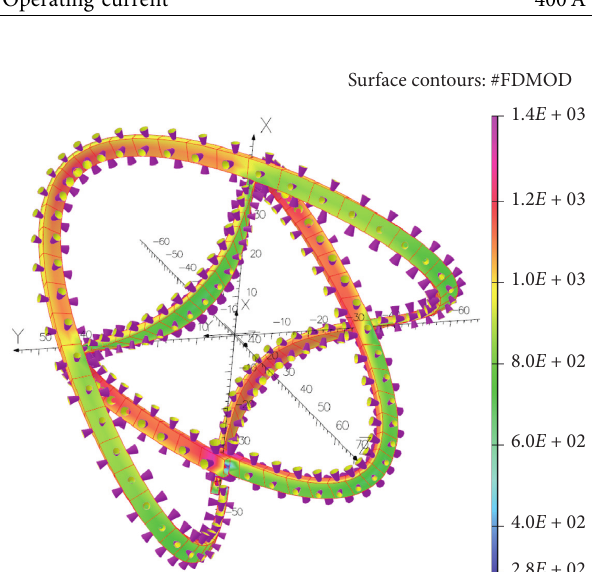
Figure 7: The distribution of the Lorentz force density calculated in Opera3D by J × B